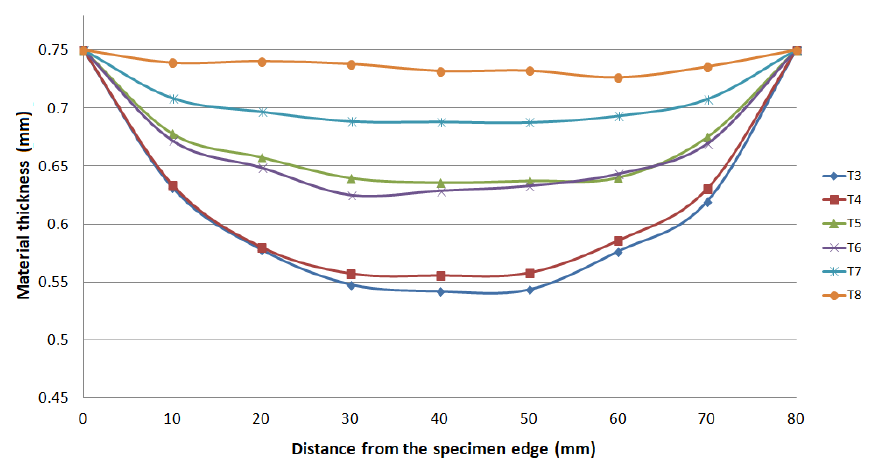
Figure 10. Material thickness values in 0 ◦ direction after bulge test evaluated by ARGUS system.